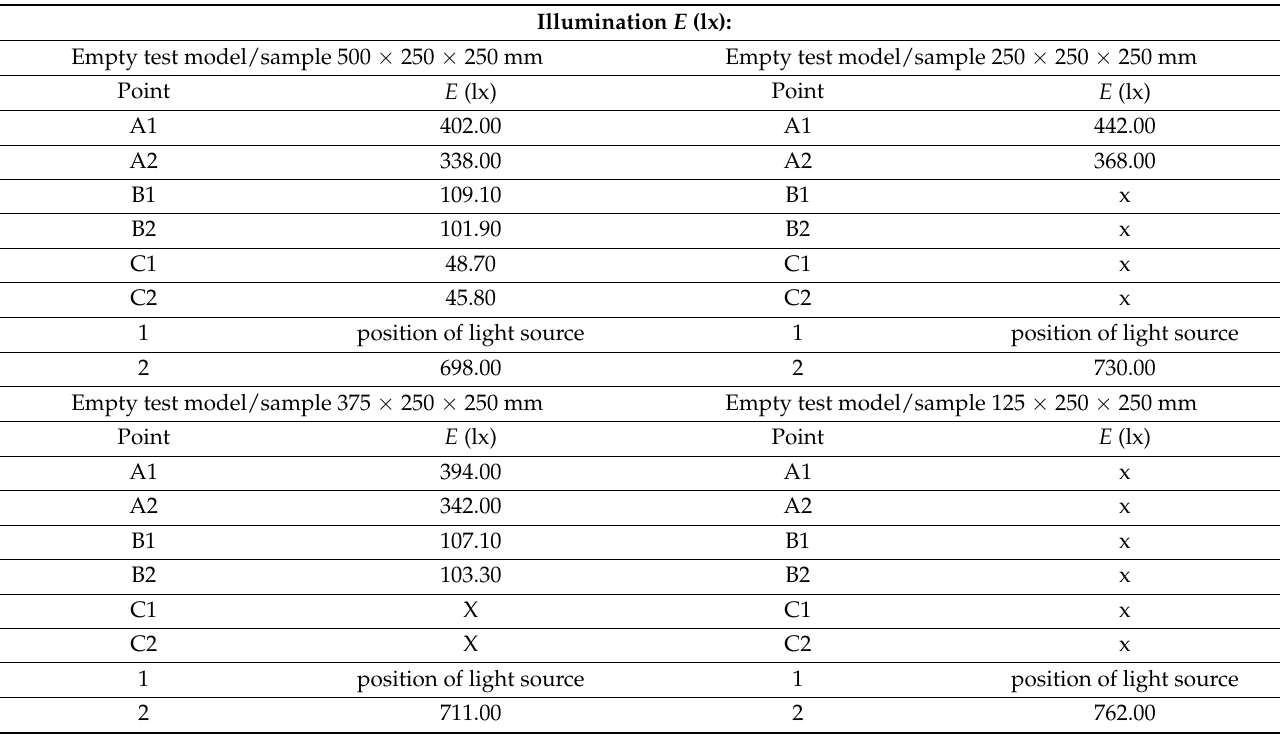
Table 9. Illumination E (lx)—Part 2. Illumination E (lx):